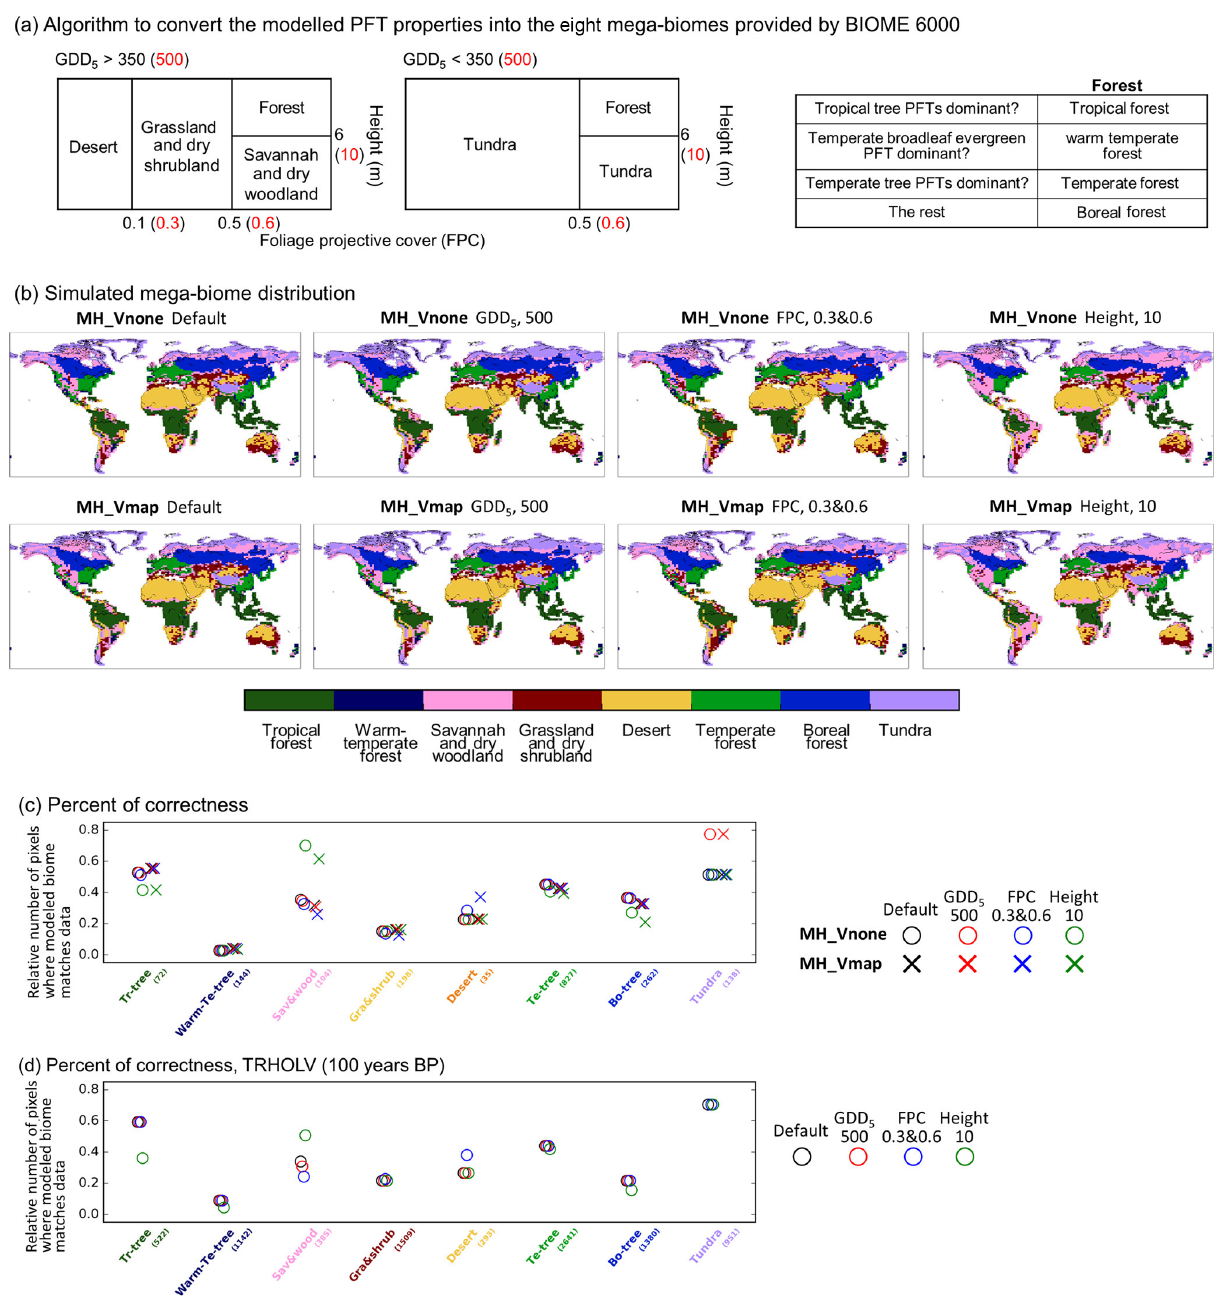
Figure A2. (a) Algorithm to convert the modeled PFT properties into the eight mega-biomes provided by BIOME 6000 DB version 1. The default thresholds (in black) are the same as Zhu et al. (2018), while different values (in red) are tested: GDD 5 (annual growing degree days above 5 ◦ C) of 500kelvin days (Joos et al., 2004), FPC (foliage projective cover) of 0.3 and 0.6 (Prentice et al., 2011), and height (average height of all existing tree PFTs) of 10m (Prentice et al., 2011). (b) Simulated mega-biome distribution by MH_Vnone and MH_Vmap, using different conversion methods to (a) . (c, d) The number of pixels where the modeled mega-biome matches data for each biome type, divided by the total number of available sites for that biome type, for the Mid-Holocene compared with BIOME 6000 6ka (c) and for the preindustrial period compared with BIOME 6000 0ka (d)